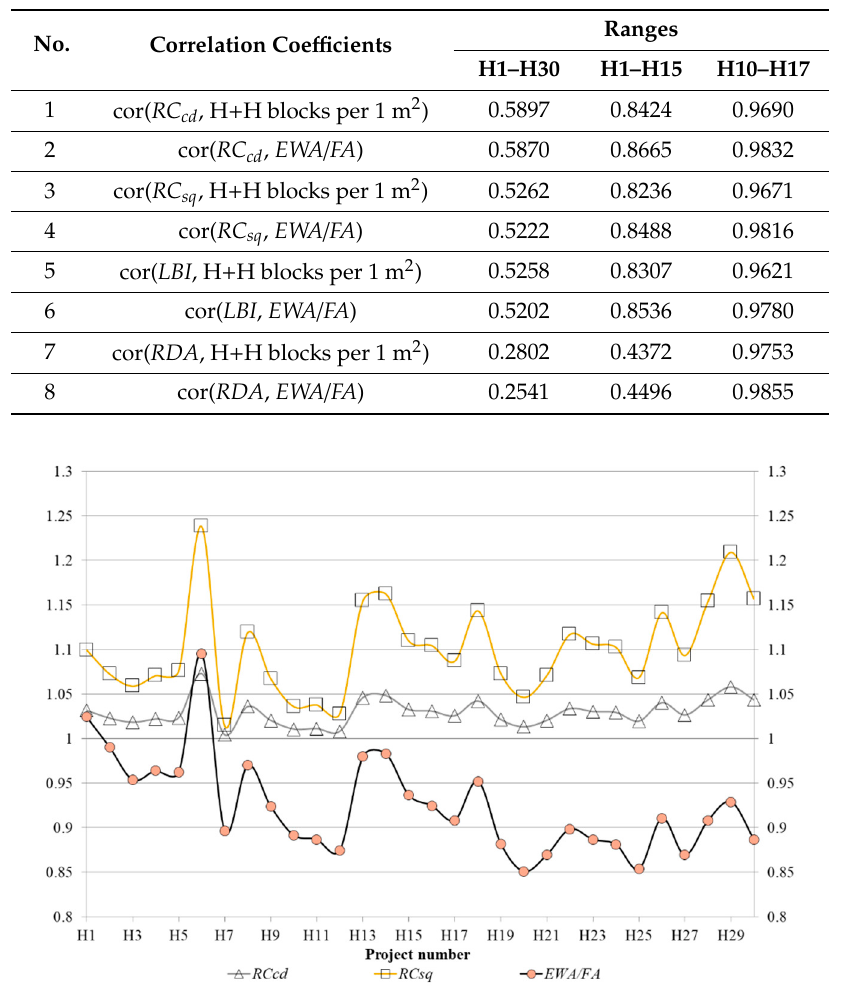
Figure 4. Visible correlation between the relative compactness indicator with respect to the cuboid ( RC cd ) and ratio of the external walls area to the floor area ( EWA / FA ) indicators at the level cor( RC cd , EWA / FA ) = 0.5870 in the full range of H1–H30 area variation (Table 1). RC sq : relative compactness indicator with respect to a square.